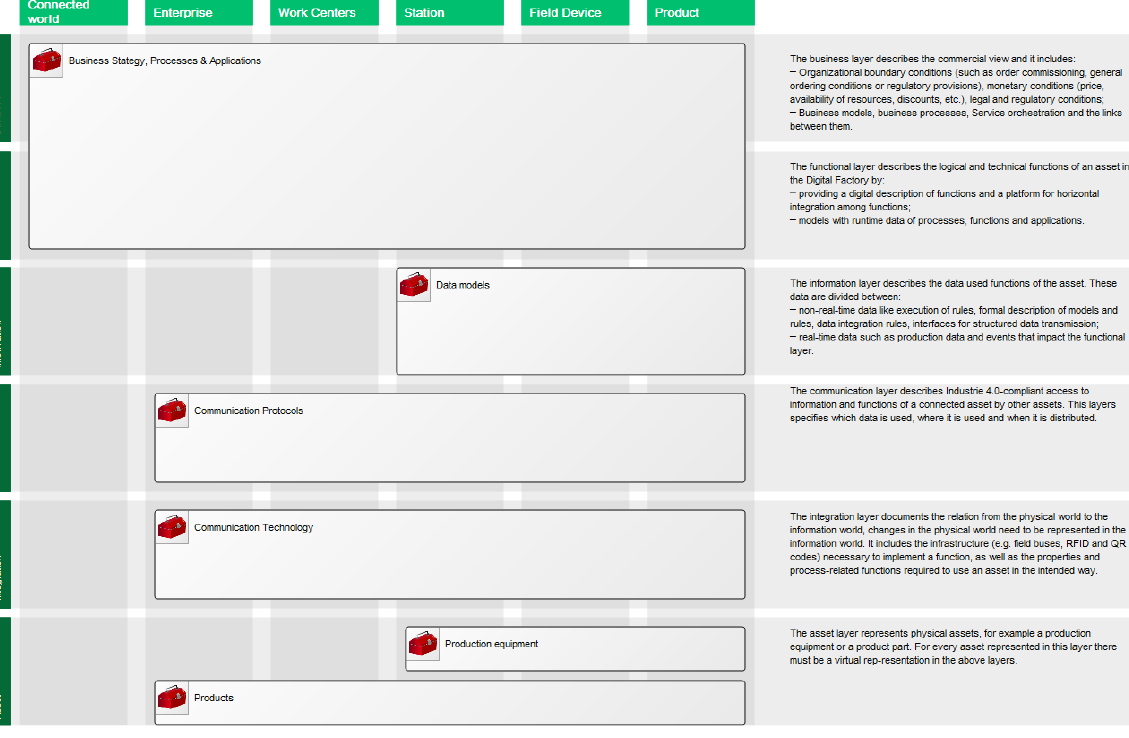
Figure 5. RAMI4.0 framework